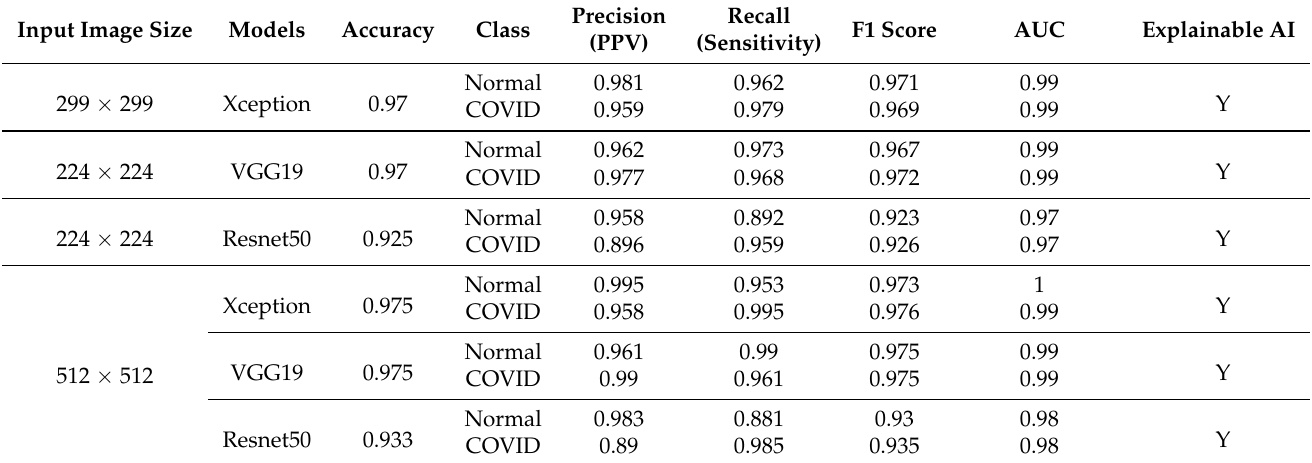
Table 2. Performance measures for the three models considered in the article for two class classification.